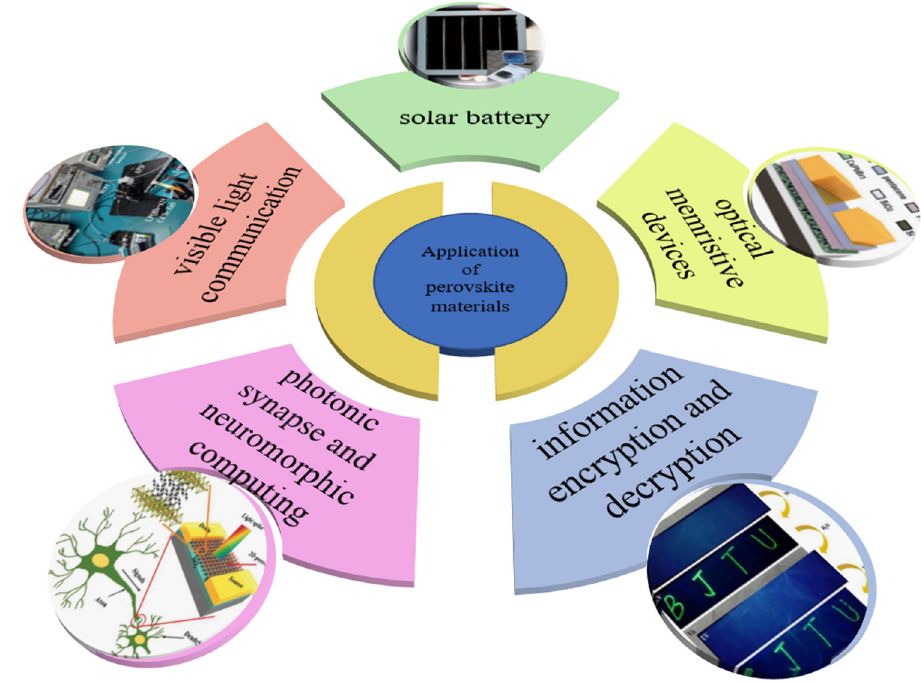
Figure 1: Schematic diagram of the application of perovskite materials in various fi